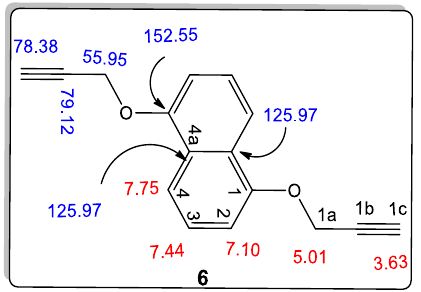
Figure 5. Structure of 1,5-bis(prop-2-yn-1-yloxy)naphthalene ( 6 ).